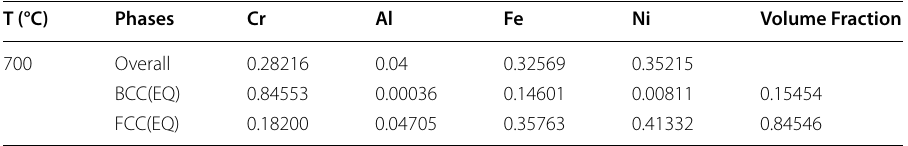
Table 4 Equilibrium phases, compositions (mole fraction), and volume fraction calculated with Thermo-Calc using TCHEA2 database T (°C)